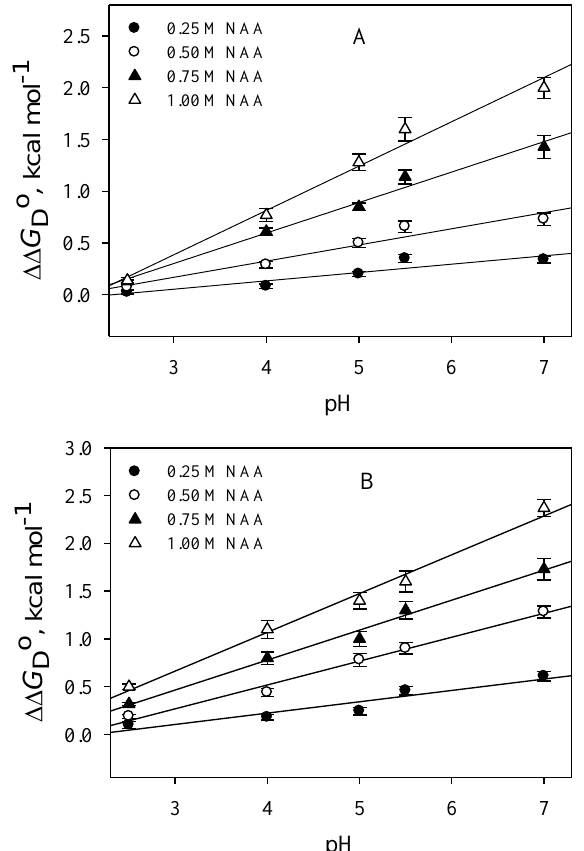
Figure 5. Plots of ∆∆ G D ◦ versus pH. ( A ) RNase-A ( B ) Lysozyme. The error shown here is from three independent measurements.